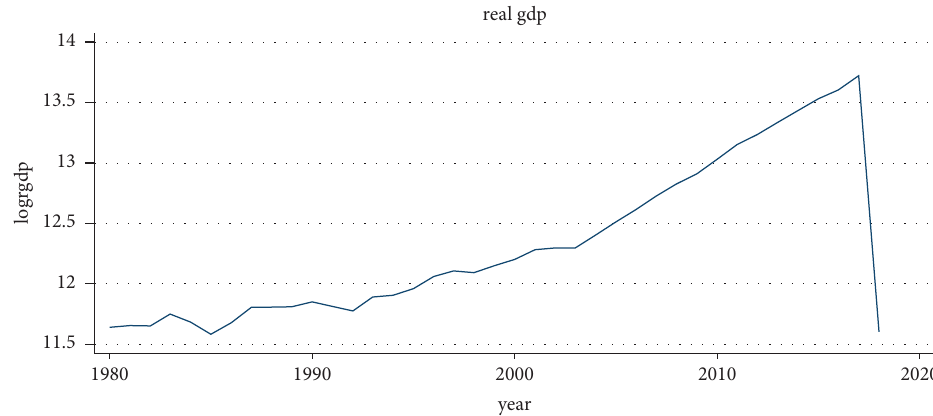
Figure 1: Trend of economic growth. Source: own computation based on the data from MOFED and National Bank, 2022.